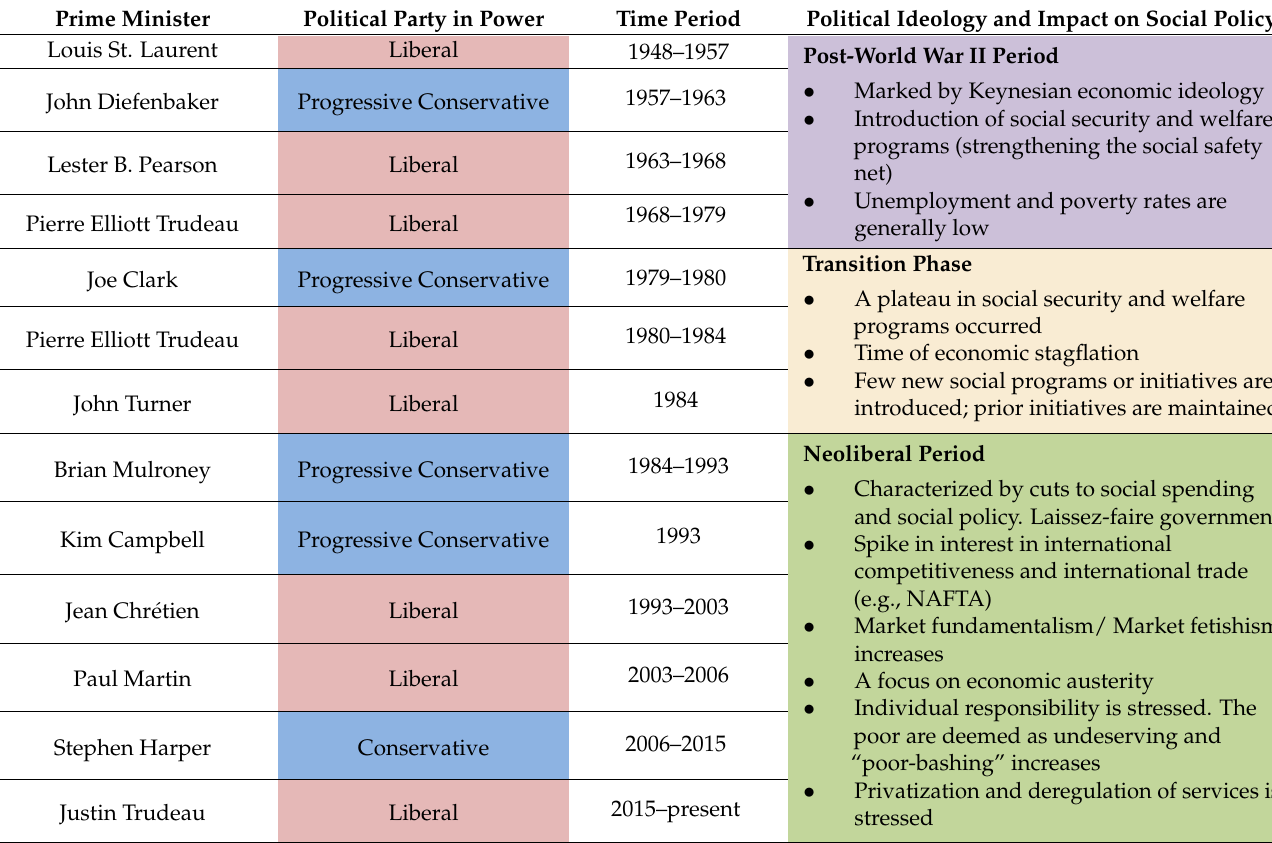
Table 1. Summary of the Prime Ministers in power at the federal level in Canada during the Keynesian period to current neoliberal times and the effect on social policy during each phase (Albert and Kirwin 2006; Harvey 2005; Parliament of Canada